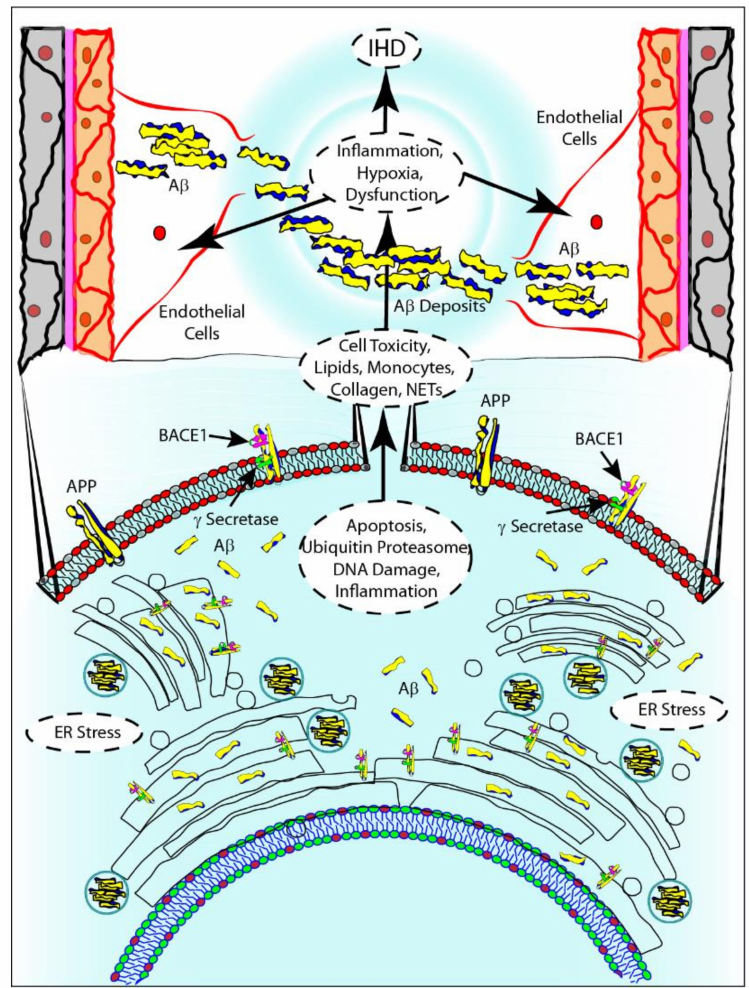
Figure 3. A β 1-40 cytotoxicity and its possible involvement in the onset of atherosclerotic plaque. A β 1-40 intracellular accumulation causes changes in the endothelial cells transcriptional profile, with a marked expression of genes related to ubiquitin proteasome system, apoptosis, DNA damage and inflammation. Cell death leads to the release of A β 1-40, which can be rapidly immobilized onto the exposed collagen and NETs, causing extracellular amyloid deposits. Consequently, inflammation, endothelial damage and clot formation increase, leading to myocardial hypoxia, dysfunction and finally to the development of IHD, independent from coronary